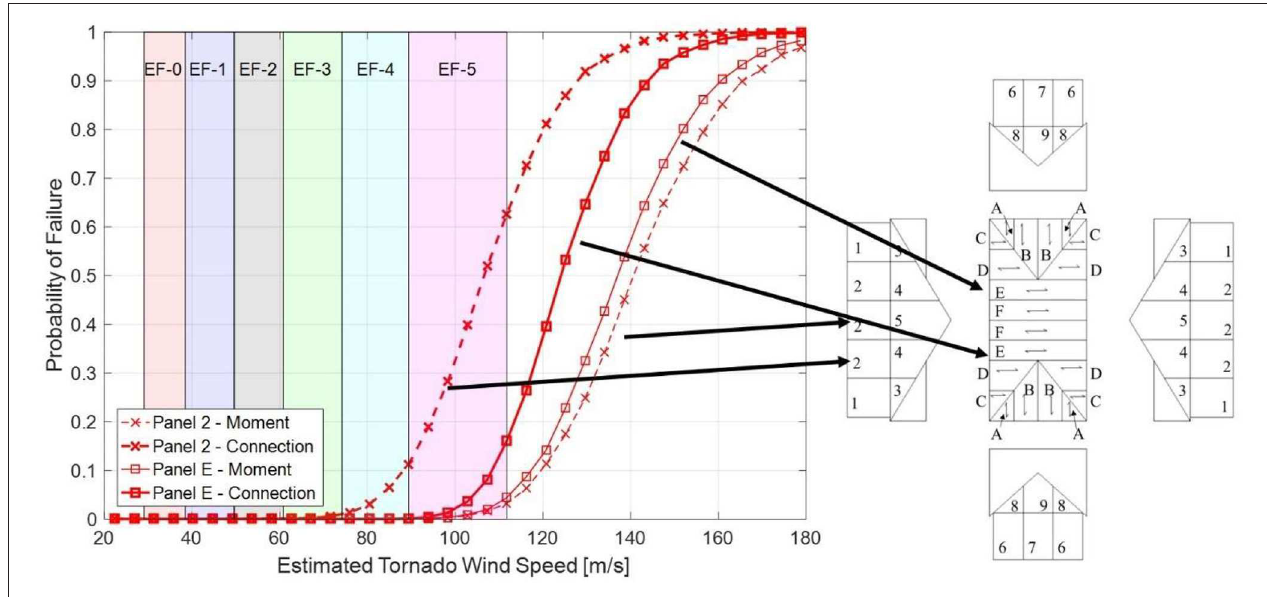
FIGURE 6 | Examples of panel fragilities developed for structure 1.